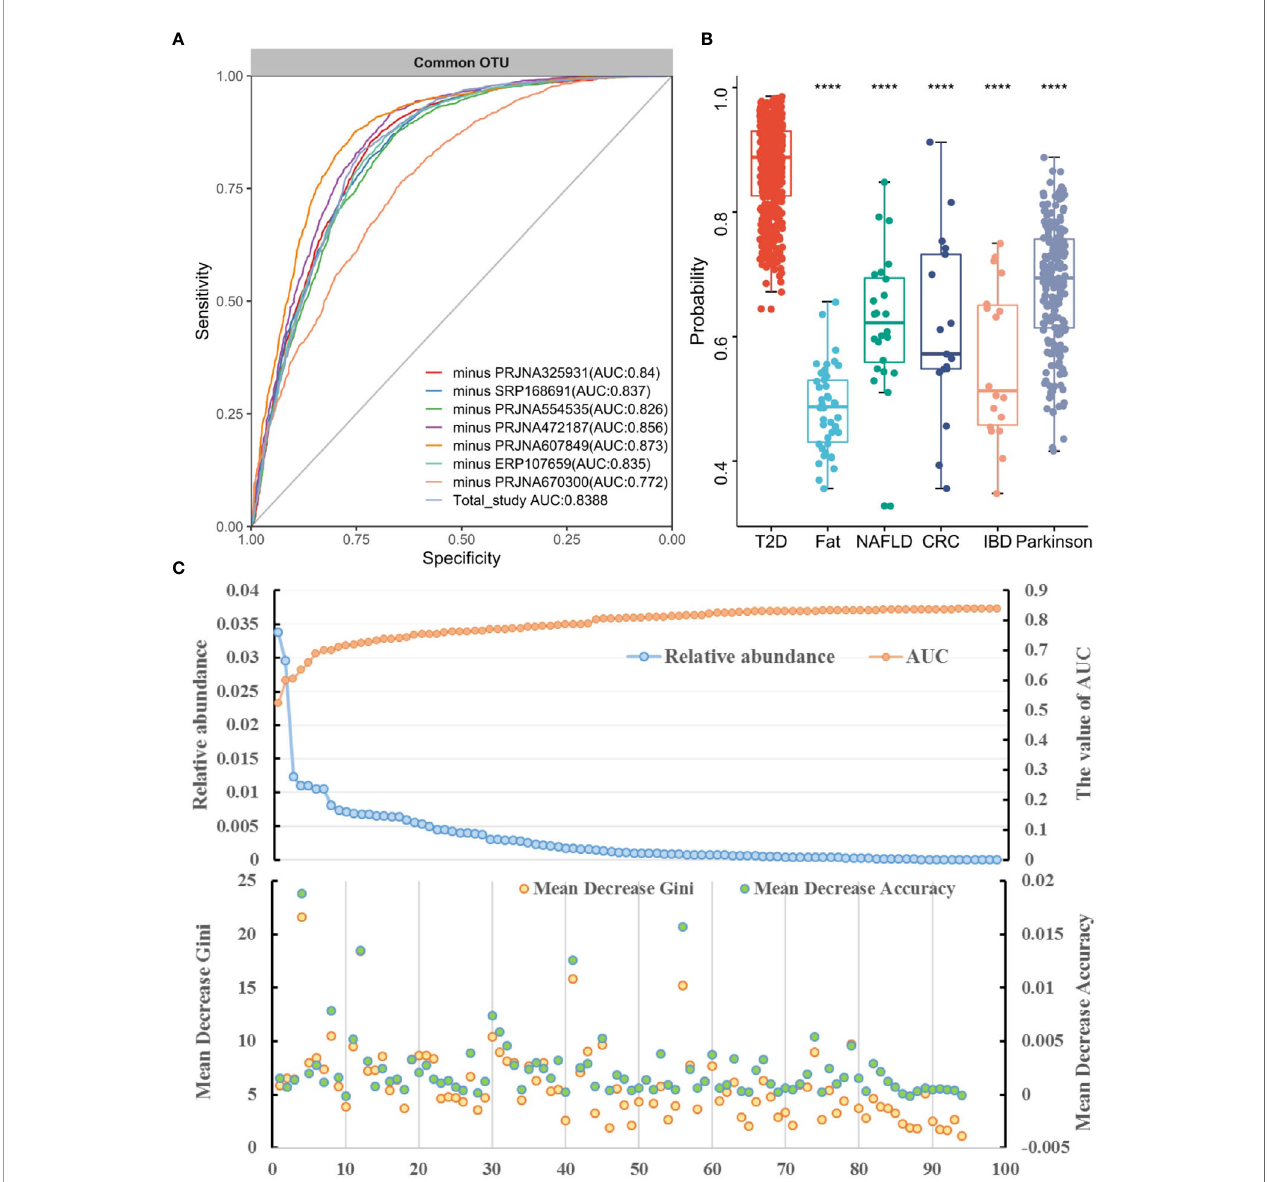
FIGURE 4 | Cross-study performance of statistical models based on OTUs. (A) ROC of data from all other studies are combined for training (LOOS validation). (B) The prediction probability relative to T2DM classi fi cation models trained on fecal samples from patients with other conditions. The "****" indicates that the predictive performance of the model between other diseases and diabetes is signi fi cantly different (t-test, p < 0.05). (C) The relative abundance, AUC value and feature ranking of the selected 96 OTUs based on two-step feature